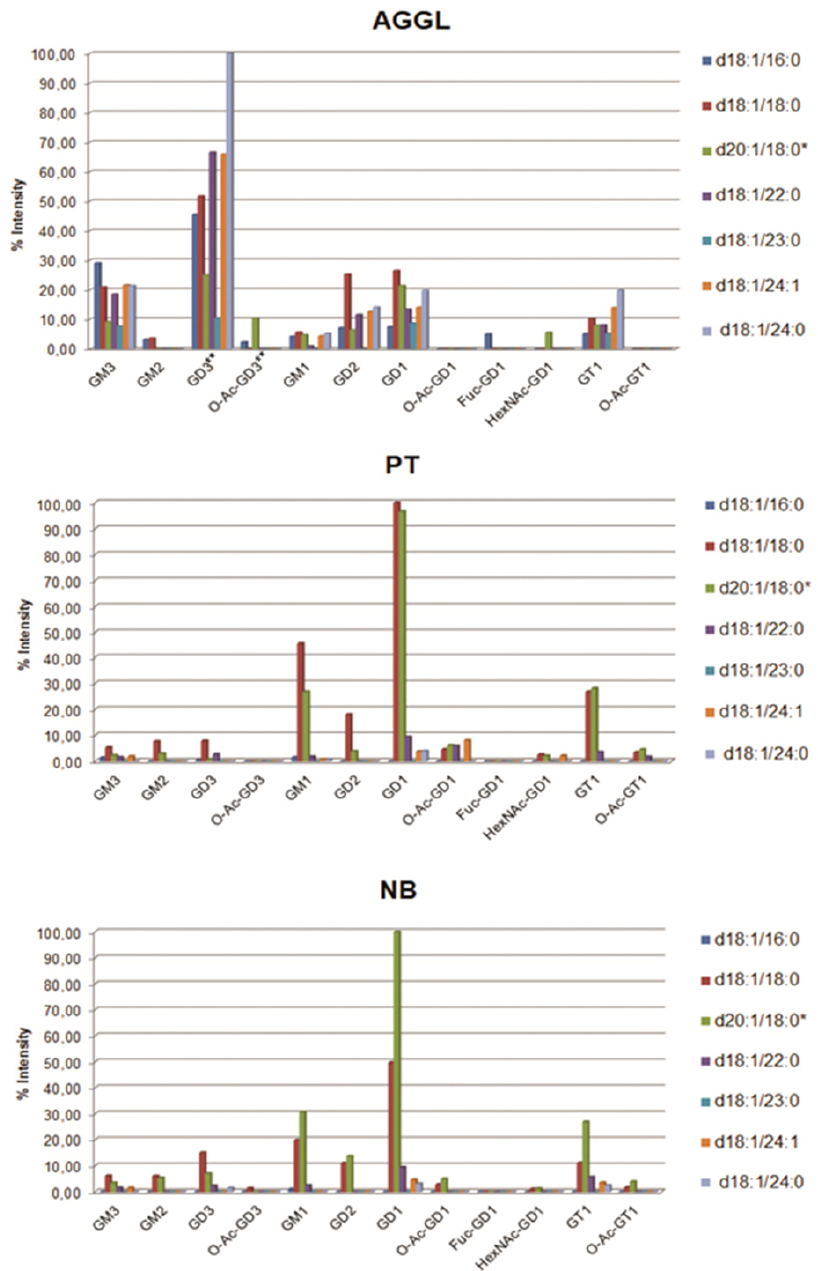
Figure 2. Ganglioside species characterized by variable ceramide structures and their relative abundances (relative ion intensities) detected via MS analysis of purified ganglioside mixtures from anaplastic ganglioglioma, peritumoral tissue and normal adult human brain tissue. * d20:1/18:0 and/or d18:1/20:0, ** O -Ac-GD3 (d20:1/18:0) and GD3 (18:1/23:0) in AGGL are present as a mixture; their relative proportions are roughly divided in half.